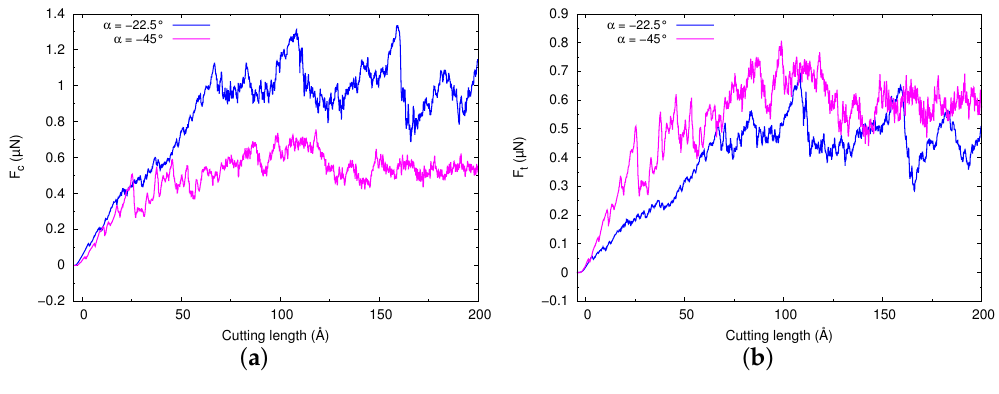
Figure A3. ( a ) Cutting force, F c , and ( b ) thrust force, F t , as a function of the cutting length L for an extended simulation up to 200 Å for the negative rake angles, α = − 22.5 ◦ and − 45 ◦